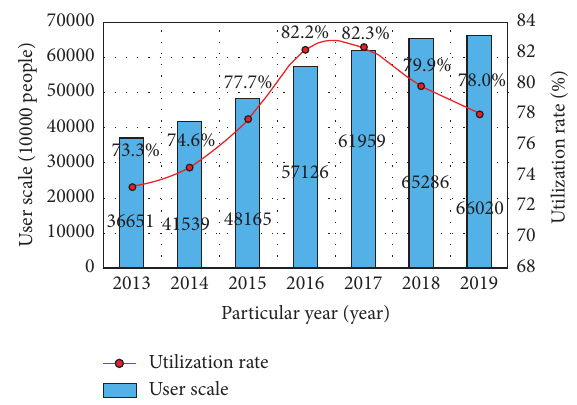
Figure 1: Scale and utilization rate of mobile Internet news users from 2013 to the first half of